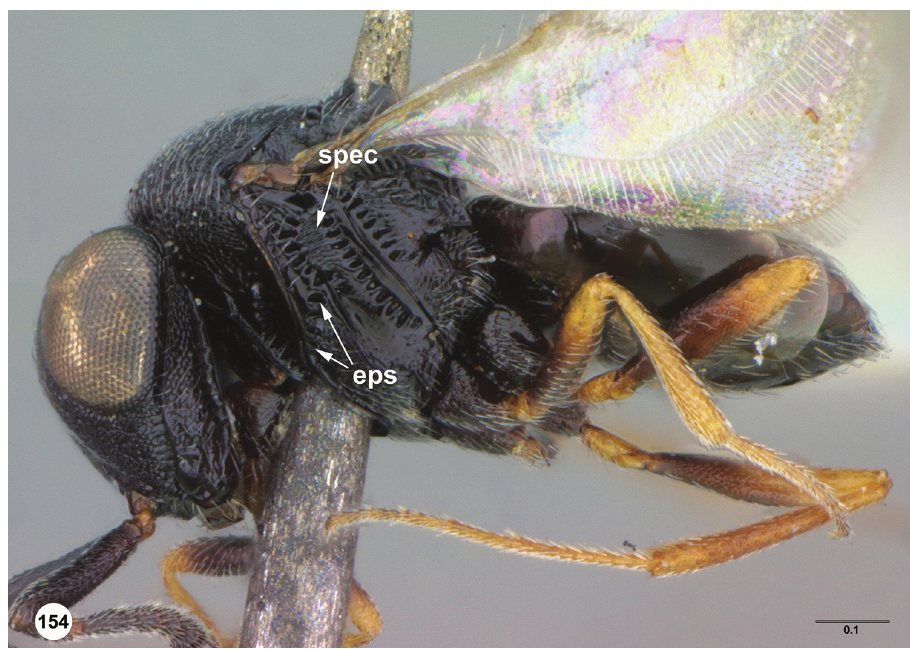
Figures 154. Trissolcus scutellaris female lectotype of T. simoni (USNMENT01059022b), head, meso- soma, metasoma, lateral view. Scale bars in